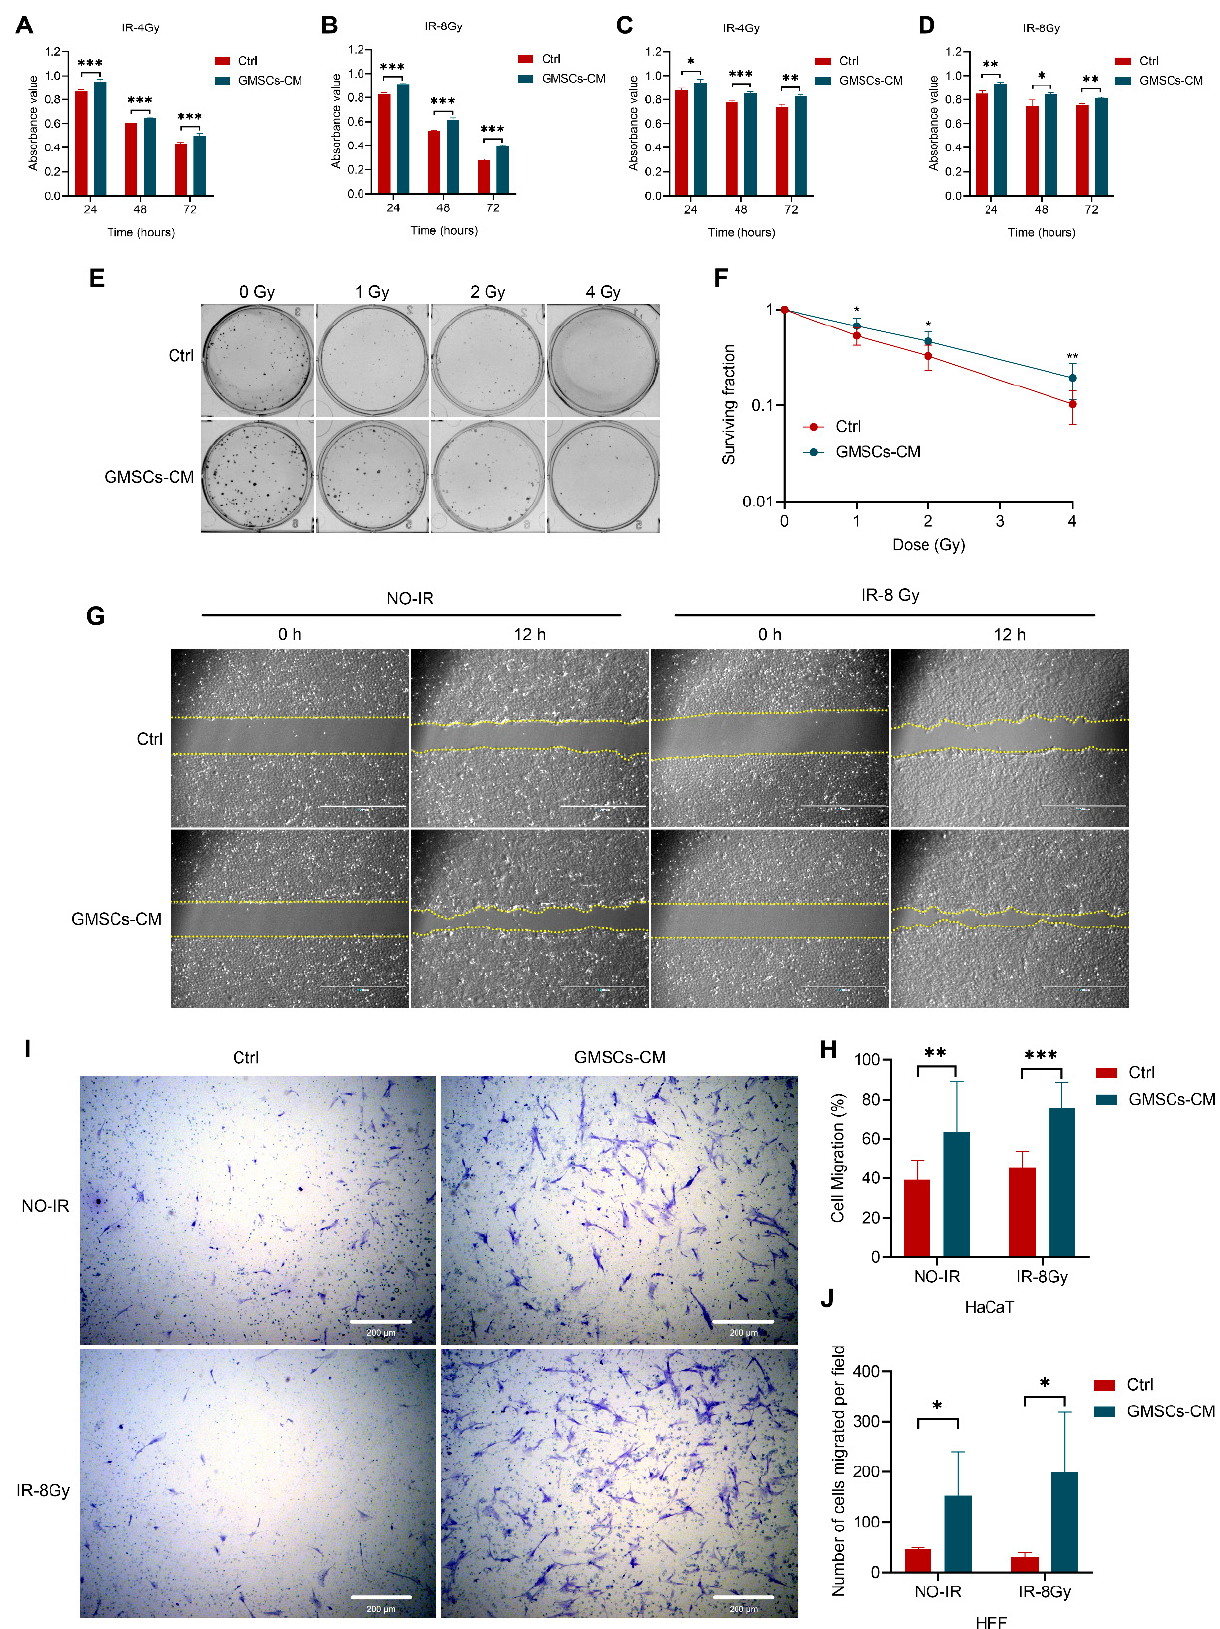
Figure 3. GMSCs promote the proliferation and migration of skin cells. ( A , B ) CCK-8 assay of HaCaT cell proliferation. ( C , D ) CCK-8 assay of HFF cell proliferation. ( E , F ) HaCaT cells were exposed to